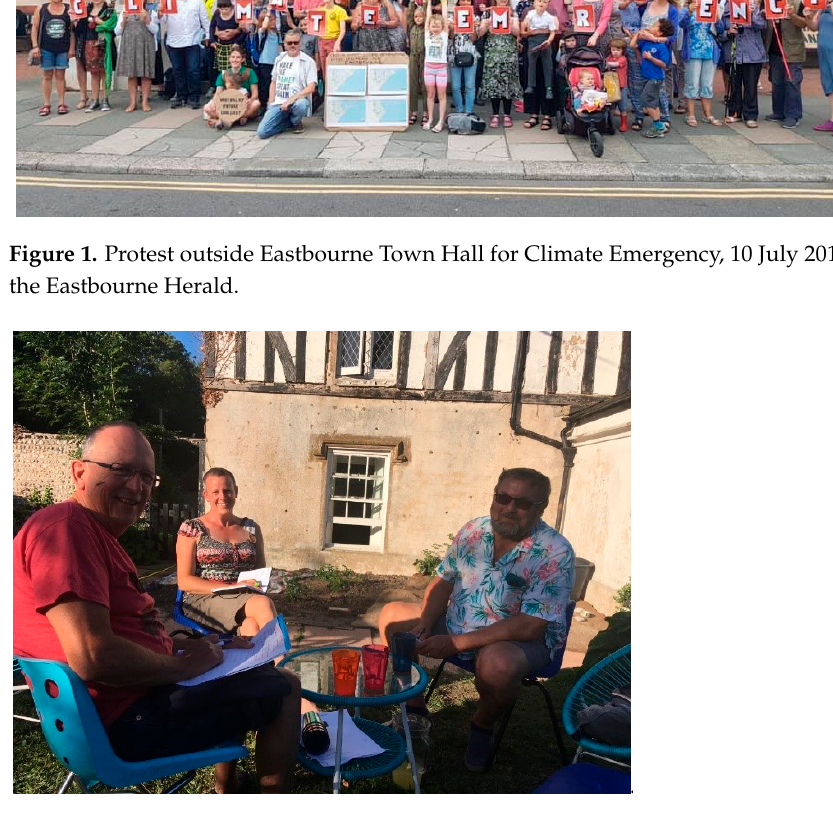
Figure 2. First education group meeting at Langney Priory, 15 July 2019 @ P von Hellermann.